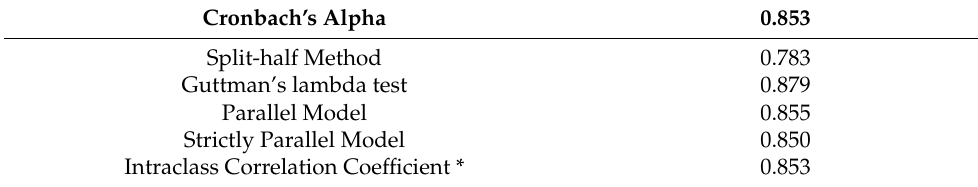
Table 5. Reliability